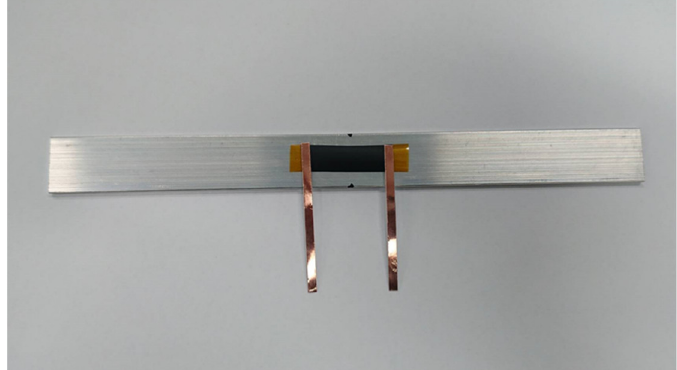
Figure 11. Nanomaterial film sensor bonded on an Al test specimen.